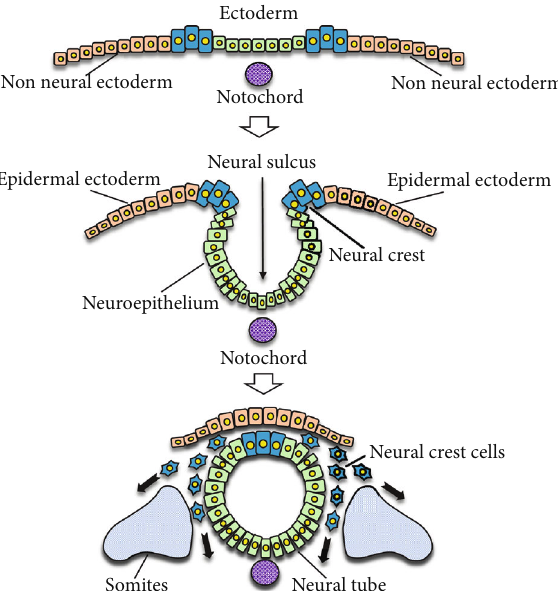
Figure 1: Neural crest formation. DPSCs are derived from neural crest